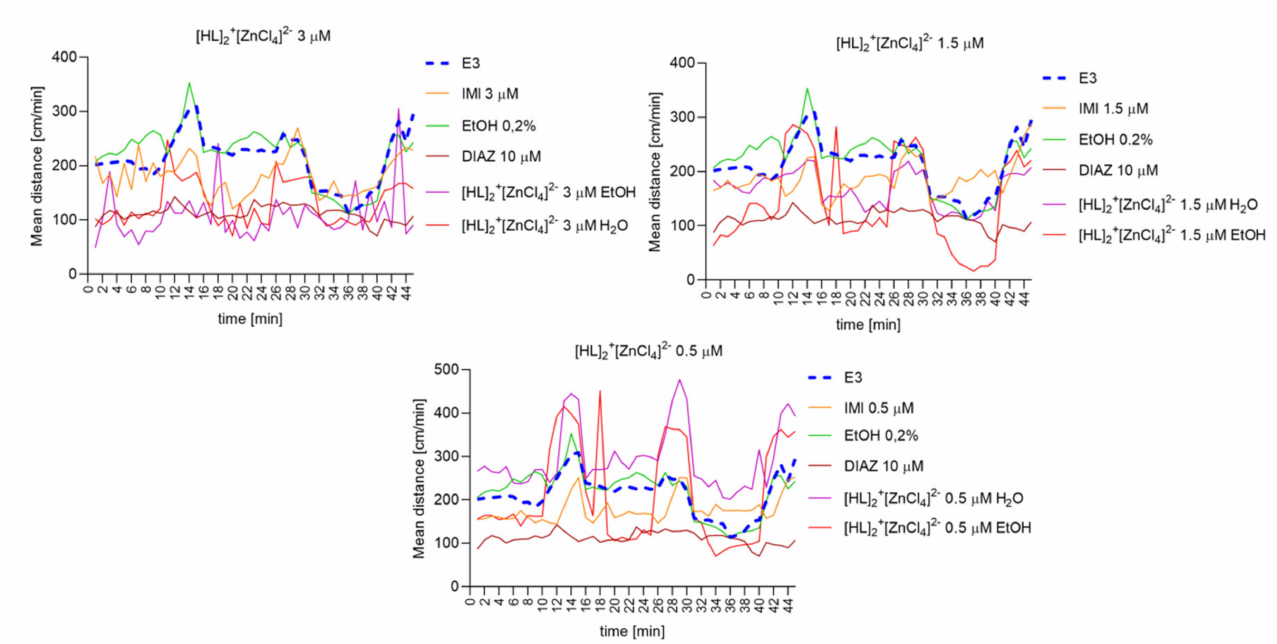
Figure 13. The changes detected during 45 min of the locomotor activity test (three 15-min light–dark sessions: 0–10-min of illumination followed by 11–15 min of darkness, 16–25 min of illumination followed by 26–30 min of darkness, and 31–40 min of illumination followed by 41–45 min of darkness) after 40 min of continuous illumination) under the influence of different concentrations of [HL] 2+ [ZnCl 4 ] 2 − in the solvent-dependent and light–dark-dependent manner of changes.